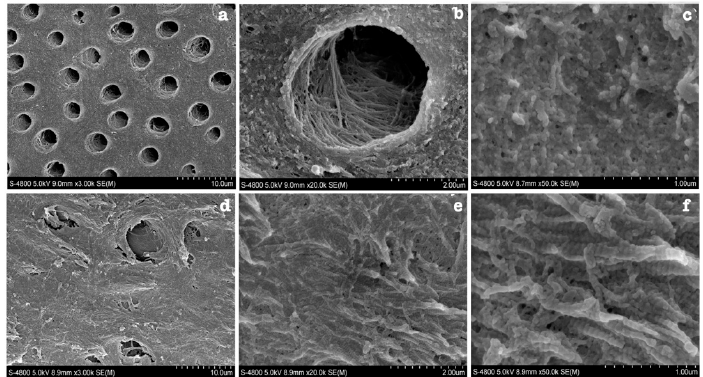
Figure 6. SEM image of normal dentin ( a – c ) and OIDI dentin (d – f ). ( a , b ) control dentin has regular dentinal tubules and ( c ) has highly mineralised and organised collagen fibres. ( d ) Defective dentin occluded dentinal tubules ( e , f ) irregular organisation of exposed collagen fibres [33].